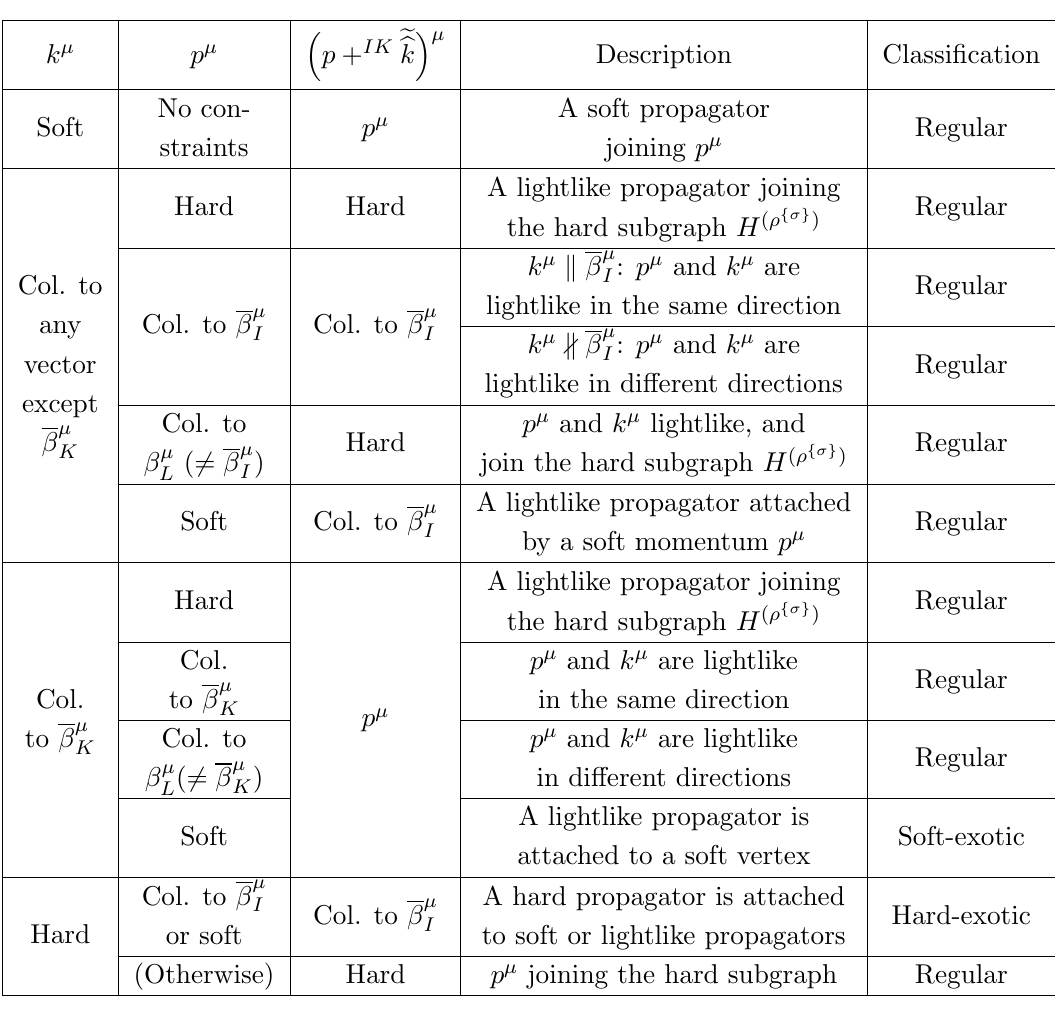
(cid:16) (cid:17) (cid:22) p + IK eb k (cid:17)